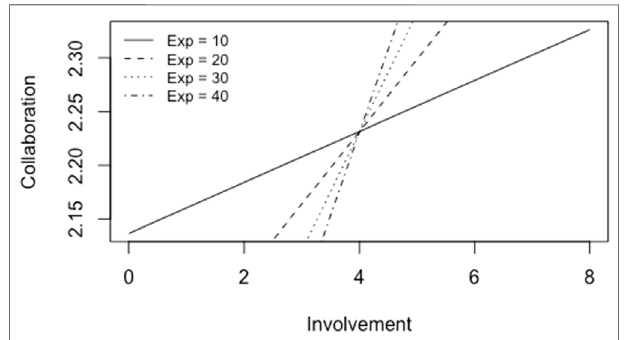
FIGURE 1 | Interaction effect between involvement in innovation and teaching